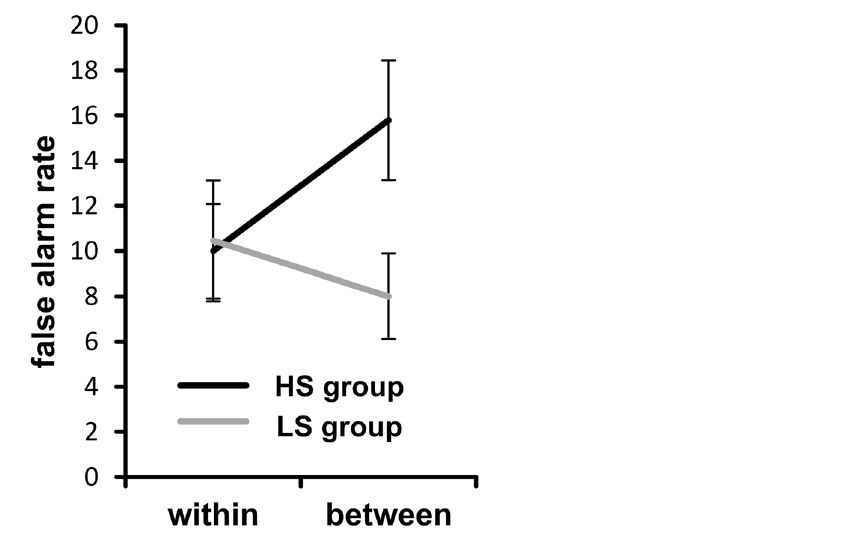
Figure 1. Behavioral data (false alarms rates) showing the interaction of condition × group. False alarm rate in the within-hand and between-hands condition is shown for the high (HS) and the low (LS) suppression group. Error bars represent the standard error of the mean (SEM).